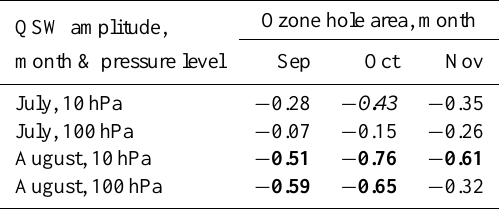
Table 1. Correlation coefficients ( r) of the QSW amplitude at 65 ◦ S in July and August with the monthly mean ozone hole area in September–November. The r-values that are significant at the 1% level (5% level) are in bold (in